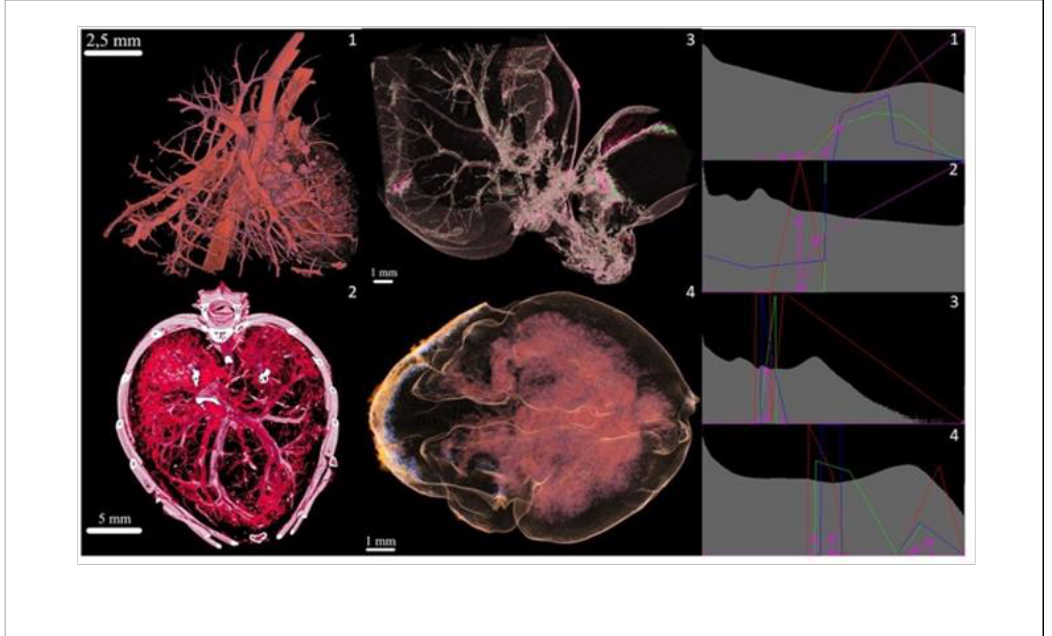
Figure 12 . Contrast agents ( left panels ) and relevant transfer functions comparison ( right panels ): 1: Rat lungs and heart (Mercox, 34 kV); 2: Mouse hull (Aurovist, 42 kV); 3: Mouse liver (Omnipaque, 40 kV); and 4: Mouse brain (KI (potassium iodide) + Ethanol, 80 kV).